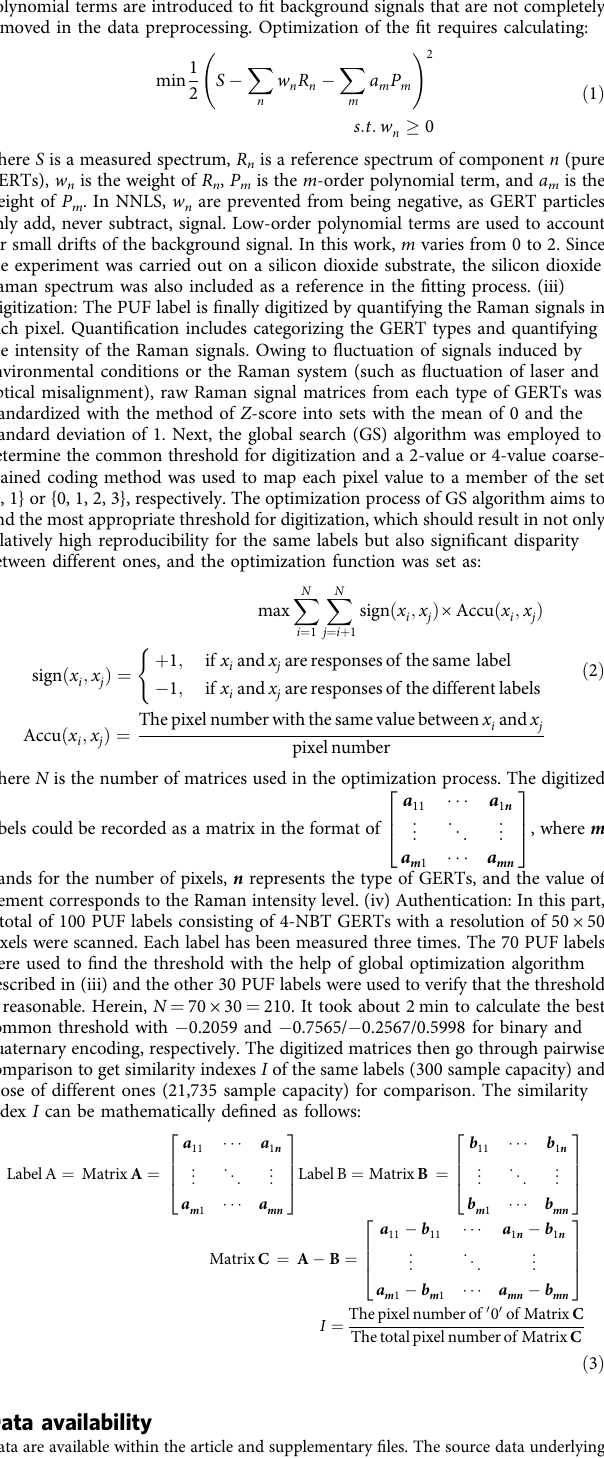
Fig. 5g, h are provided as a Source Data fi le. All other data that support the fi ndings of the study are available from the corresponding author upon reasonable request. Code